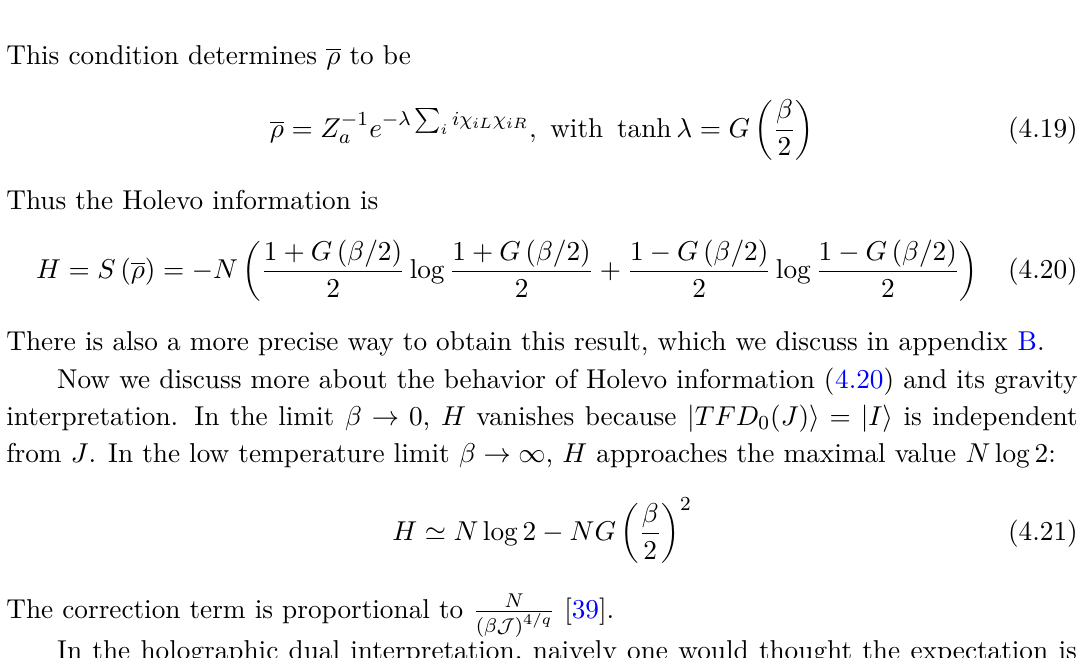
Figure 4 . The holographic dual interpretation of the Holevo information, for two different ensem- bles of states. (a) For the ensemble of SYK thermal states, the Holevo information is the generalized entropy of a small interval ˜Σ R , minus the thermal entropy. (b) For the ensemble of thermofield double states, the Holevo information is given by the generalized entropy of two small intervals Σ L Σ R . (c) An illustration of Σ L , Σ R in higher